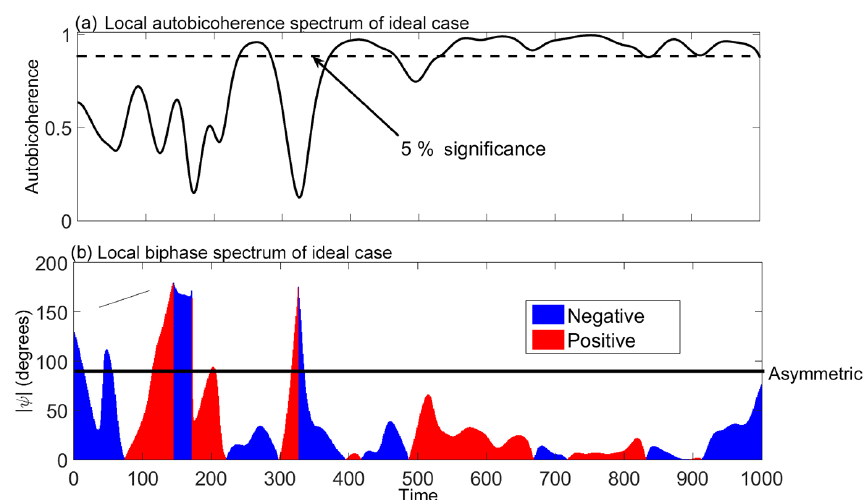
Figure 7. (a) The local autobicoherence and (b) local biphase corresponding to (30, 30) in the full autobicoherence spectrum shown in Fig. 5a. Biphases differing from 90 ◦ indicate that the nonlinear interaction resulted in a waveform with skewness.